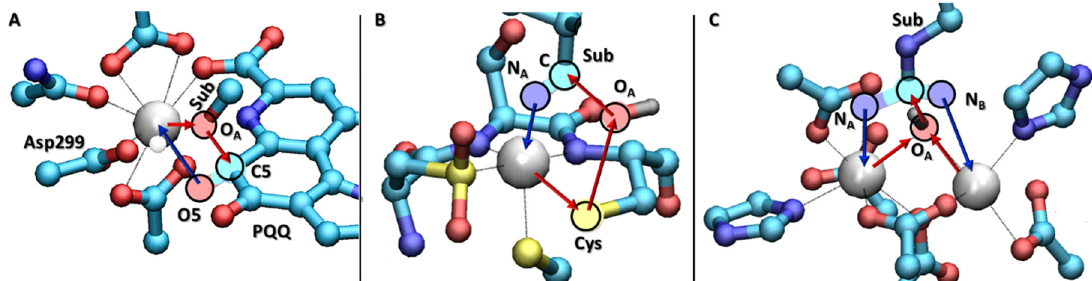
Figure 11. Optimized structures of TS1 isolated along potential energy surfaces of ( A ) Ce 3 + - and Eu 3 + -MDH, ( B ) Co 3 + - and Fe 3 + -NHase, and ( C ) Mn 2 + -Mn 2 + and Co 2 + -Co 2 +